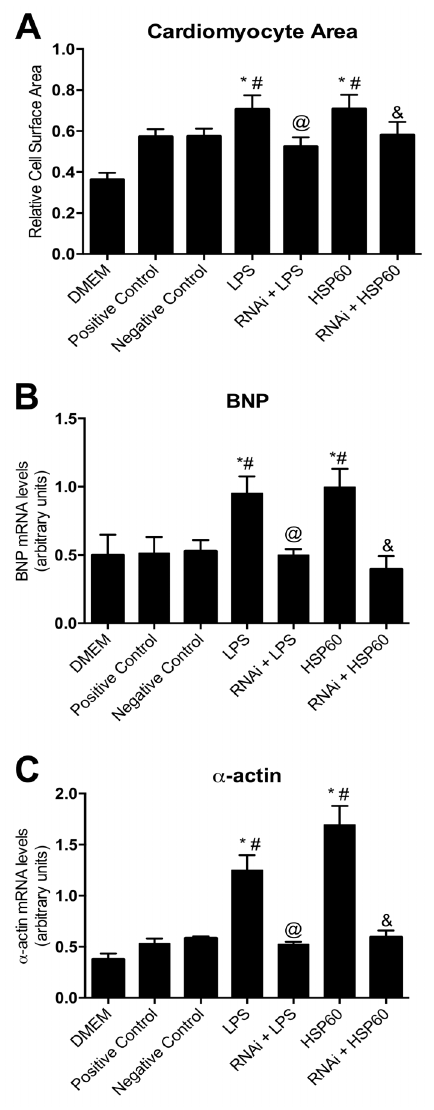
Figure 3. Silencing of CamKII d and its effects on cardiac hypertrophy. A , Relative cell surface demonstrating the cardio- myocyte area after treatments compared to control/RNAi control cells. B , Analysis of BNP (brain natriuretic peptide, cardiac hypertrophy marker) and C , α -actin (cardiac hypertrophy marker) evaluated by real time PCR in cardiomyocytes treated with 0.1 m M of the interference RNA for 48 h, followed by 100 m M of LPS or 1 m M of HSP60 for 24 h and control cells. Data are reported as means ± SE. *P o 0.05 vs DMEM, # P o 0.05 vs RNAi positive control, @ P o 0.05 vs LPS treatment, & P o 0.05 vs HSP60 treatment (n=4 in all experimental groups,